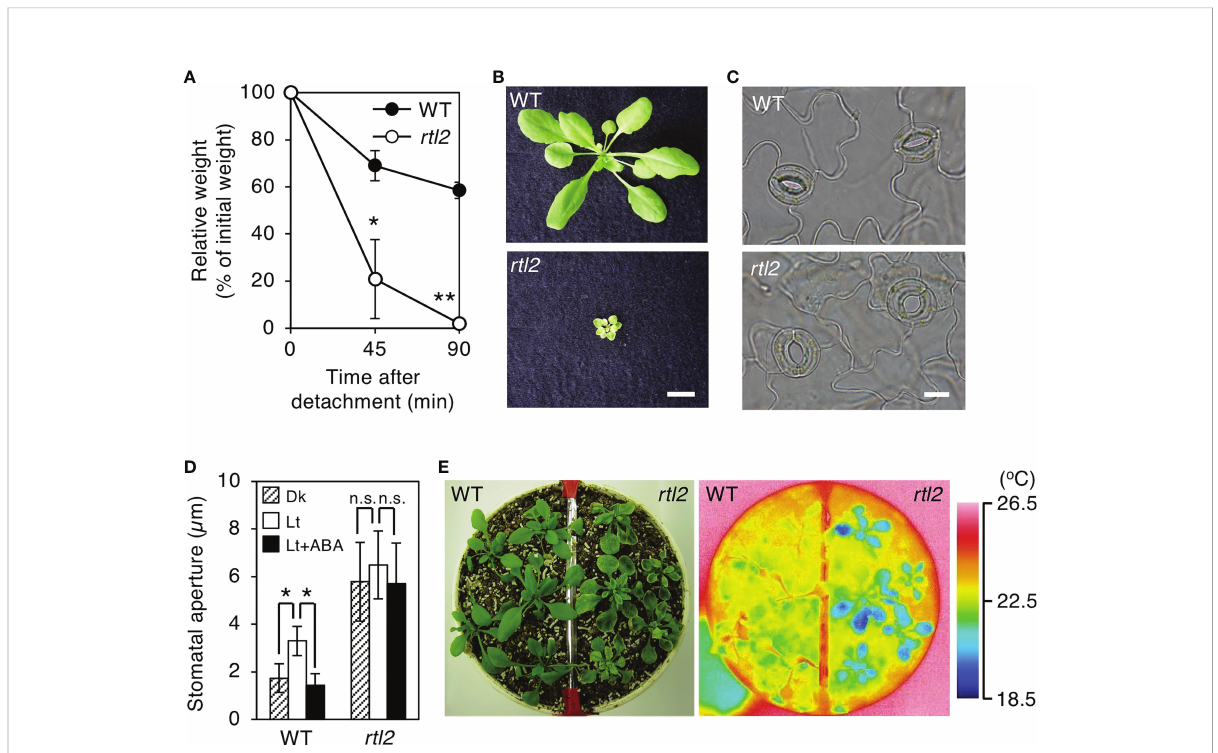
FIGURE 1 Characterization of the rtl2 mutant. (A) Kinetics of the fresh weight change in the detached rosette leaves from 4-week-old WT (closed circles) and rtl2 (open circles) plants. The relative weights of leaves are presented as a percentage of the initial weight, which was the weight of each rosette leaf immediately after detachment from the plants. Values are means of three independent experiments with SDs. Asterisks indicate a signi fi cant difference in leaf weight change relative to WT by Student t test; * P < 0.05, ** P < 0.01. (B) Four-week-old WT and rtl2 plants grown on soil. Scale bar = 1 cm. (C) Typical stomata in the epidermis of WT and rtl2 plants under illuminated growth conditions. Scale bar = 10 µm. (D) Stomatal aperture of 5-week-old WT and rtl2 plants. Plants were grown on MS plate for 4 weeks and transferred to soil for 1 week. Epidermal tissues from dark-adapted plants were incubated under light (blue light at 10 µmol m -2 s -1 superimposed on red light at 50 µmol m -2 s -1 ) with (black; Lt+ABA) or without (white; Lt) 20 µM ABA or kept in the dark (hatched; Dk) for 2.5 hr. Values represent mean ± SD (n = 3); measurement of > 25 stomata in each experiment. Asterisks indicate a signi fi cant difference by Student t test; * P < 0.05. n.s., not signi fi cant. (E) Thermal image (right) and the corresponding bright- fi eld image (left) of WT and rtl2 plants. The images of the 5-week-old plants were grown on MS plate for 4 weeks and transferred to soil for 1